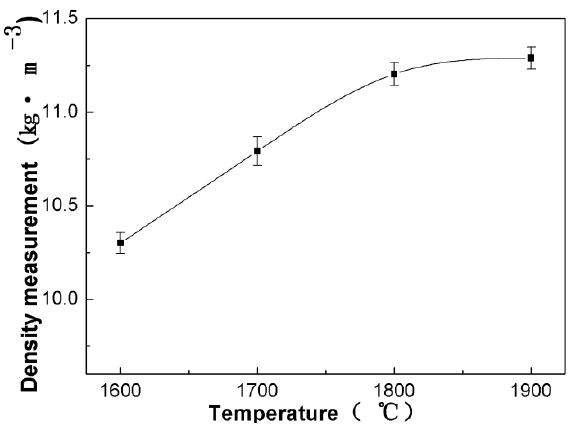
Figure 5. Density of WB 2 samples versus temperature at pressures of 5.2 GPa for 15 min.